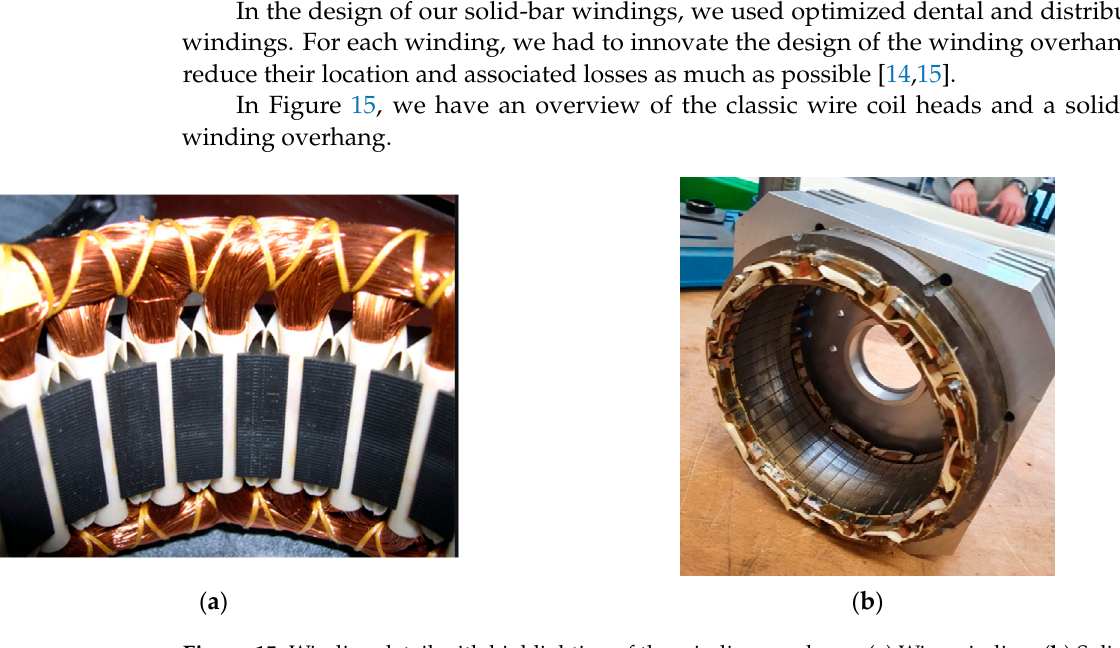
Figure 15. Winding detail with highlighting of the winding overhang: ( a ) Wire winding, ( b ) Solid-bar winding.